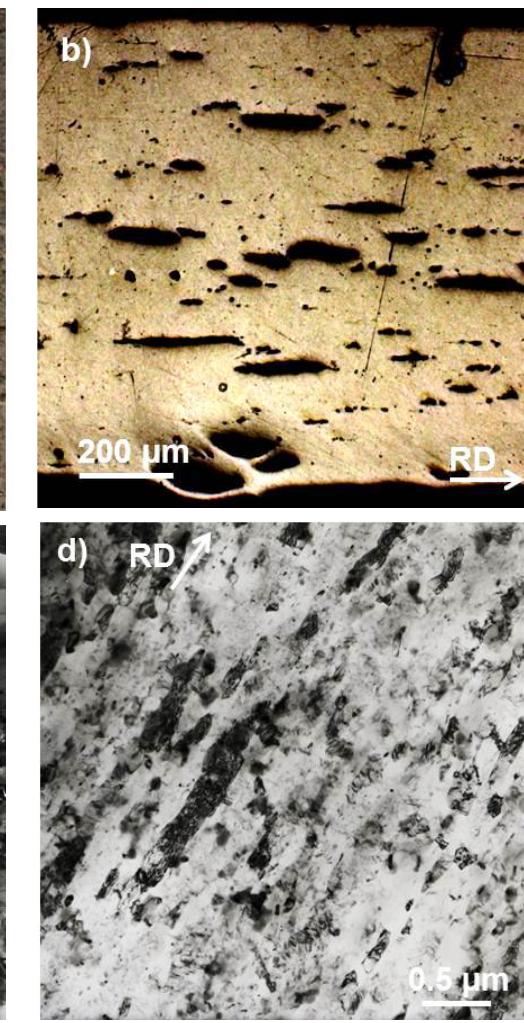
Figure 1. Copper particle reinforced ultrafine-grained aluminum after nine ARB cycles in ( a ) optical micrograph showing distribution of copper particles in aluminum and ( c ) transmission electron micrograph showing copper particles and local precipitation and structure refinement in their vicinity; ( b ) optical micrograph in the PS + annealed state showing the complete dissolution of copper particles and Kirkendall porosity; ( d ) TEM of AA2017A after four ARB cycles. Please note: RD indicates rolling